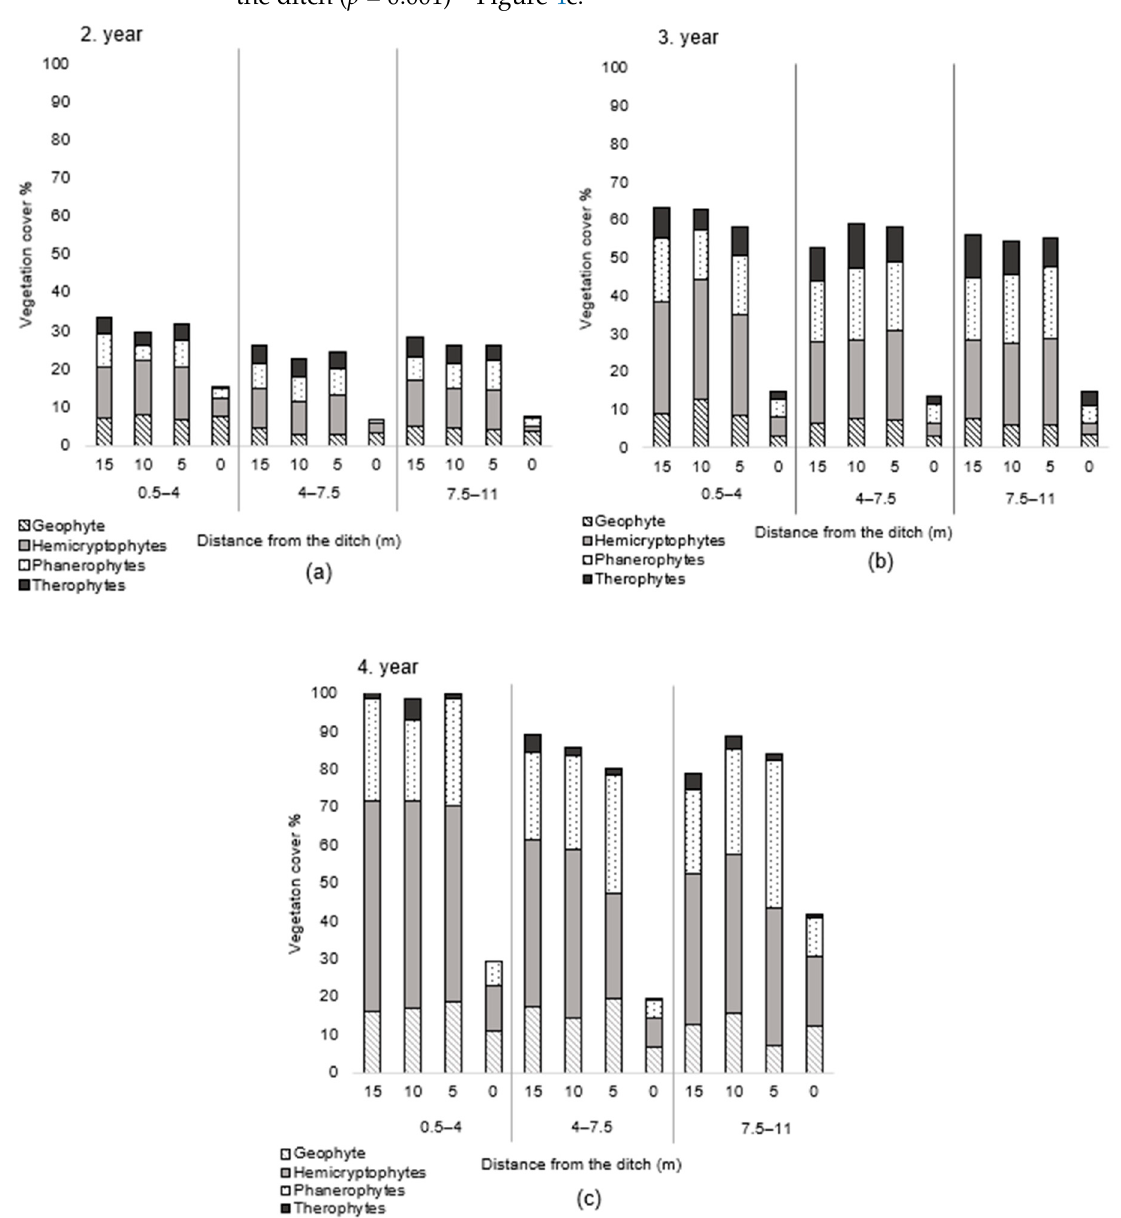
Figure 4. Plant growth form proportion from total vegetation cover depending on different doses of wood-ash fertiliser and distance from the drainage ditch: ( a ) second year after fertilisation; ( b ) third year after fertilisation; ( c ) fourth year after fertilisation.